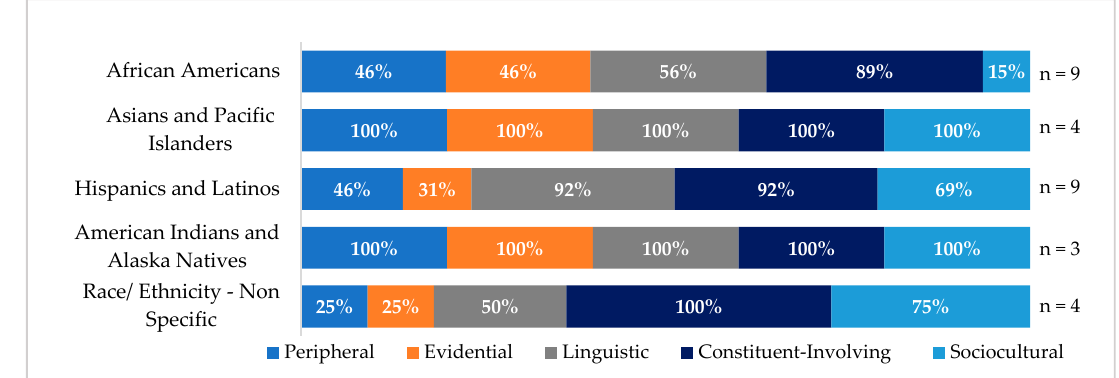
Figure 3. Cultural tailoring strategies by race and ethnicity.